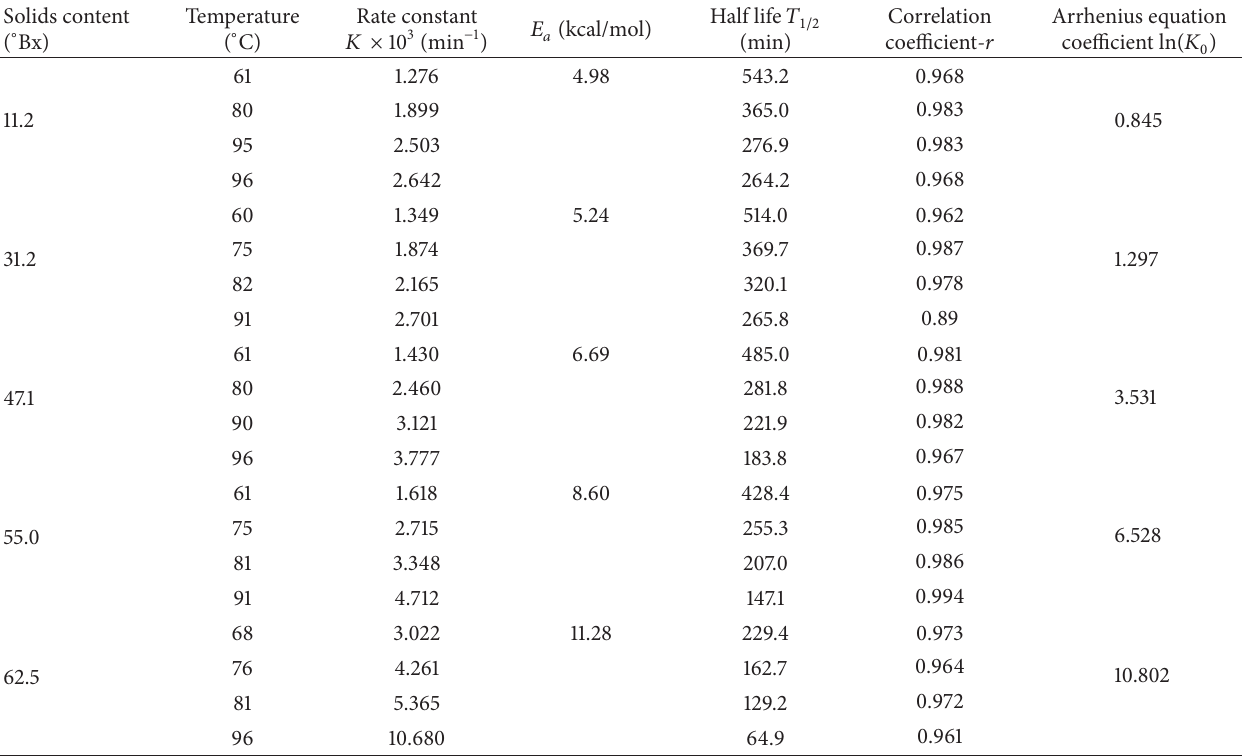
Table 9: Effect of temperature and solids content on degradation of ascorbic acid in grape juice and concentrate. Adapted from [215]. Solids